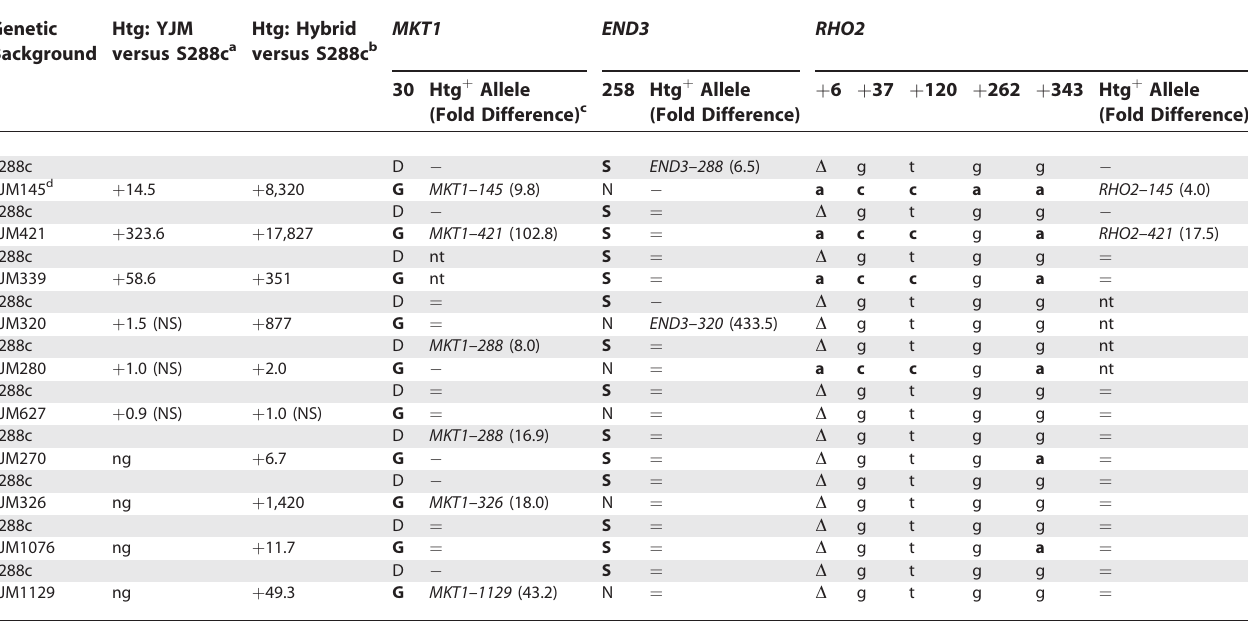
Table 6. Htg Phenotypes and RHA of Htg Genes in Hybrids between S288c and Other S. cerevisiae Genetic